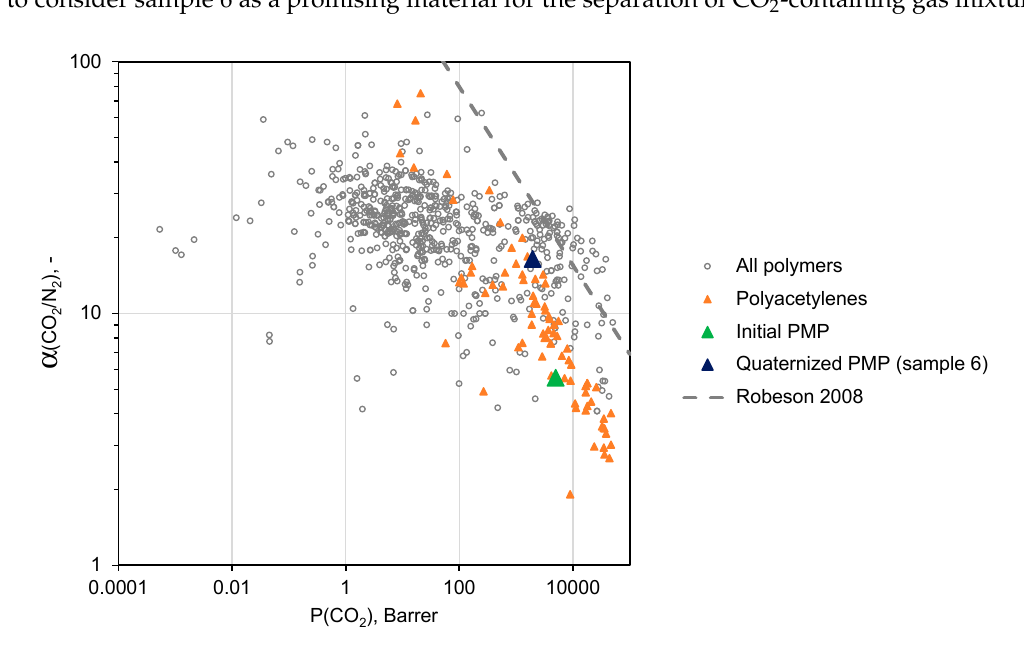
Figure 10. Robeson diagram for CO 2 /N 2 mixtures.